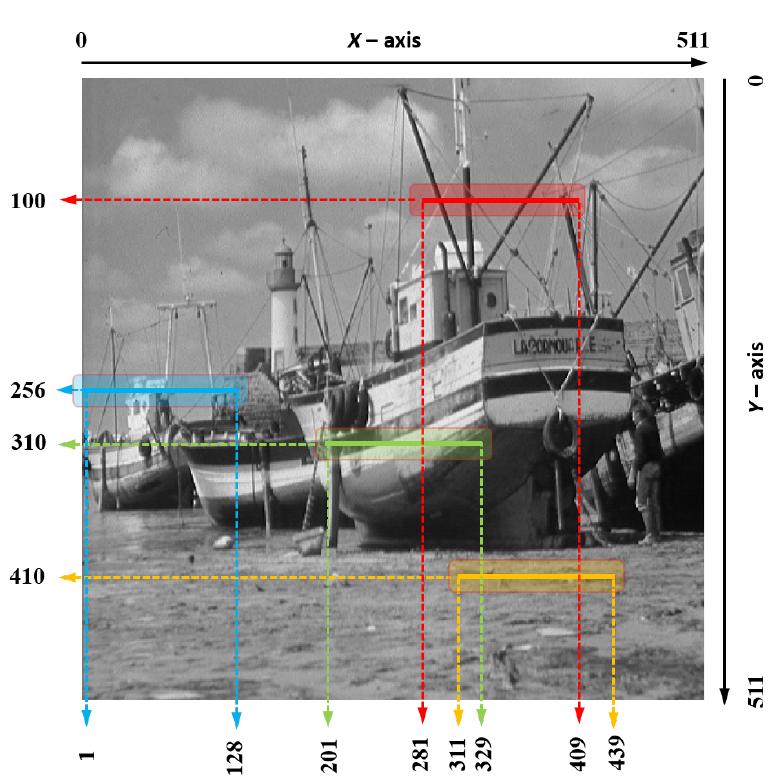
Figure 8. Test grayscale image with the size of 512 × 512 (Boat): extracted 1D signals with the length of 128 highlighted by red, blue, green, and orange colours.